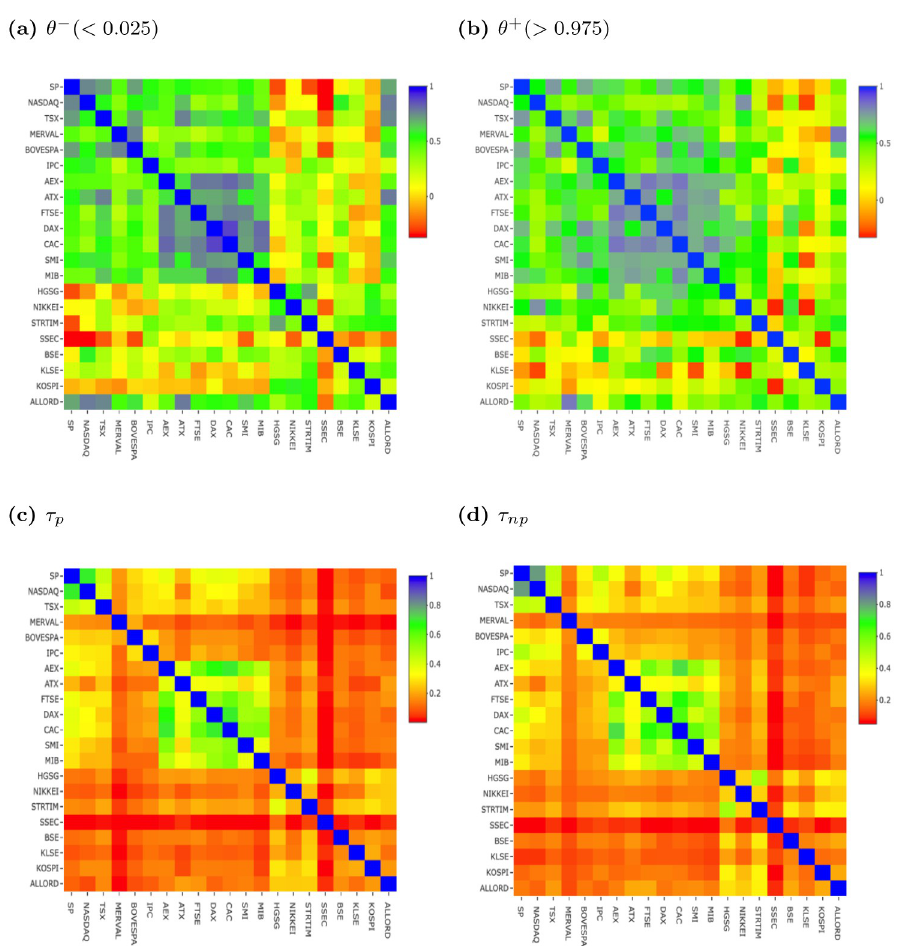
Fig 9. Full sample results—Comparing measures. (a) θ − ( < 0.025), (b) θ + ( > 0.975), (c) τ p , (d) τ np